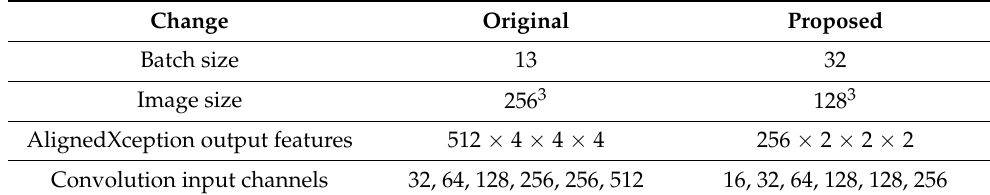
Table 6. AlignedXception architectural